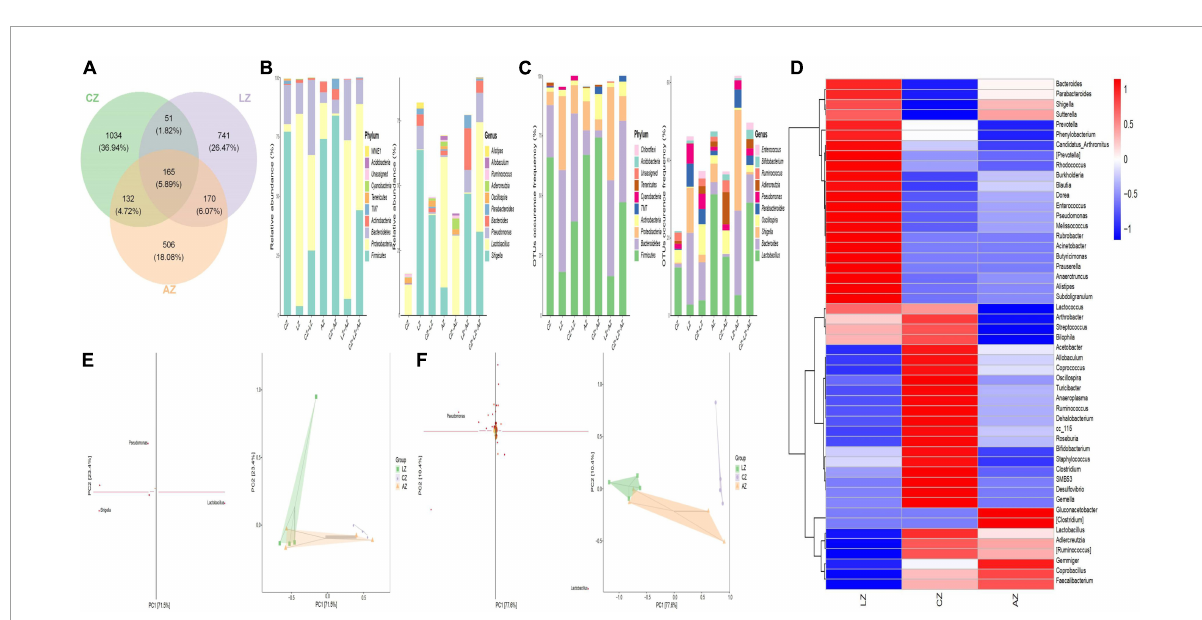
FIGURE7 Different species and marker species analysis in mouse microbiota induced by LPS. (A) Venn diagram, (B) bar chart of ASV/OTU numbers in different regions of Venn diagram, (C) bar graphs of ASV/OTU abundance in different regions of the Venn diagram, (D) genera composition heatmap, (E) PCA, and (F)